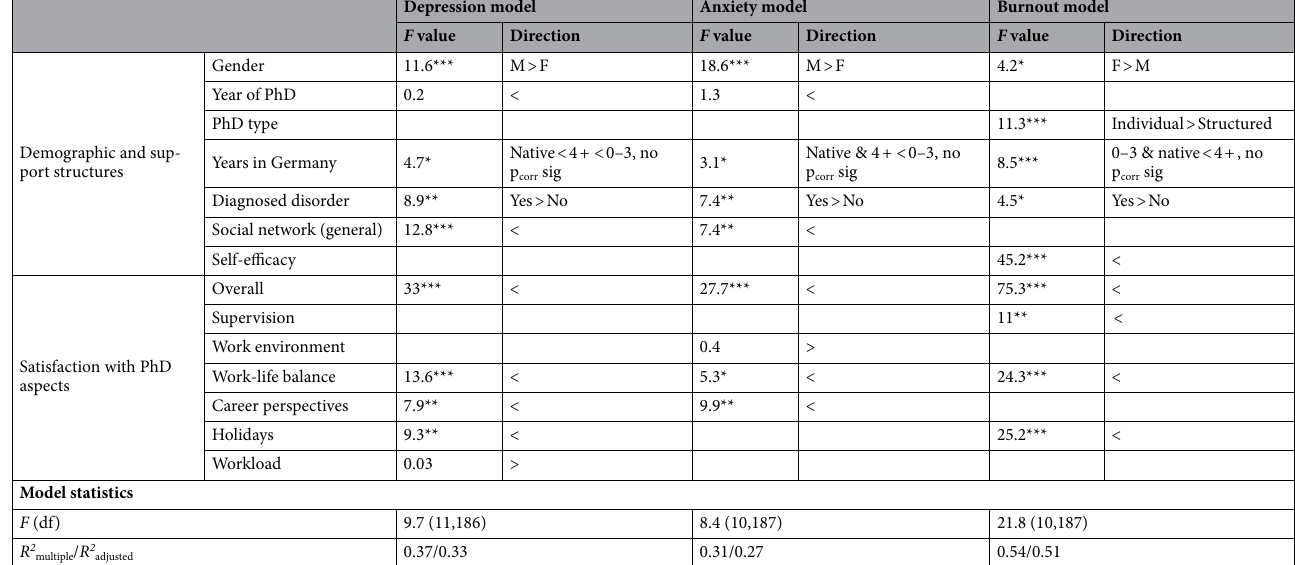
Table 2. Statistics and directions of the effects in the exploratory models for depression, anxiety, and burnout. Columns “direction” include information on whether increasing values of the predictor were linked to increasing ( >) or decreasing ( <) values of the dependent variables (questionnaire scores). Post-hoc comparisons with Holm correction were administered for “Years in Germany” in all models, but none of